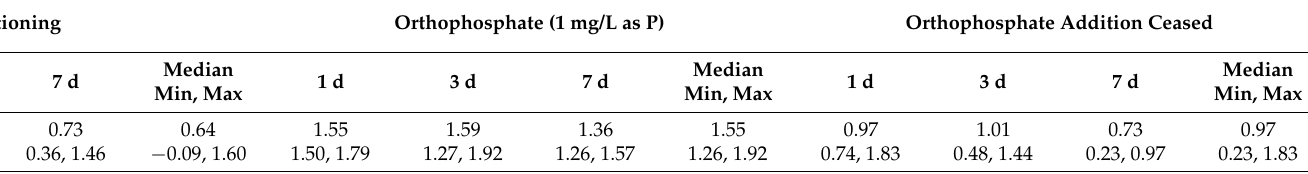
Table 2. Change in pH values with respect to initial tap water pH in samples collected at different stages from the system. Sequential